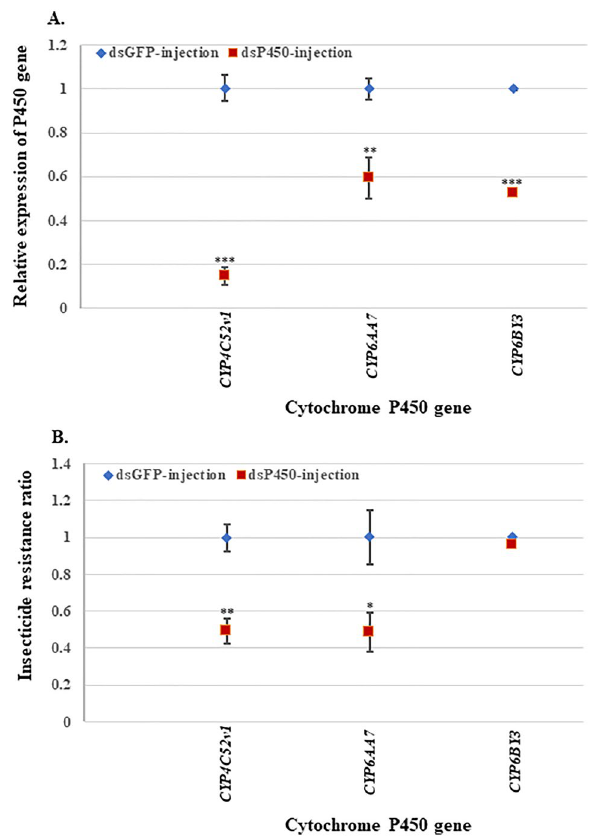
Figure 2. Knockdown of P450 genes associated with permethrin resistance in adults of Cx. quinquefasciatus . RNAi was conducted in the adults of the permethrin resistant mosquito strain, HAmCq G8 . DsRNA of P450 and GFP genes were individually injected into 1-d-old female adults of Culex mosquitoes. ( A ) Gene expression was detected by real-time PCR in female adults, showing significantly decreased expression of P450 genes compared with GFP injection mosquitoes. ( B ) Permethrin sensitivity was determined by adult bioassay, indicating increased susceptibility to permethrin in dsRNA of 2 P450 gene injection mosquitoes compared with GFP- injection ones; the negative control showed no increased susceptibility to permethrin in the dsRNA of non- overexpressed P450 gene injection mosquitoes. The data shown are the mean ± SEM (n ≥ 3). The student’s t-test was used for significance analysis. *P < 0.05; **P < 0.01; ***P <